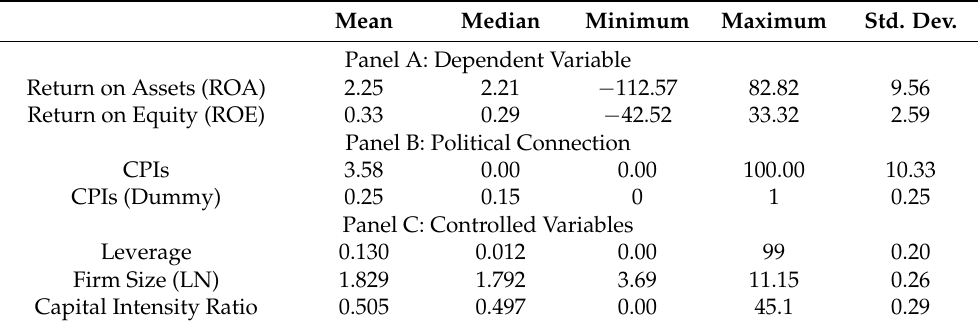
Table 5. Descriptive statistic (2012–2017, n =